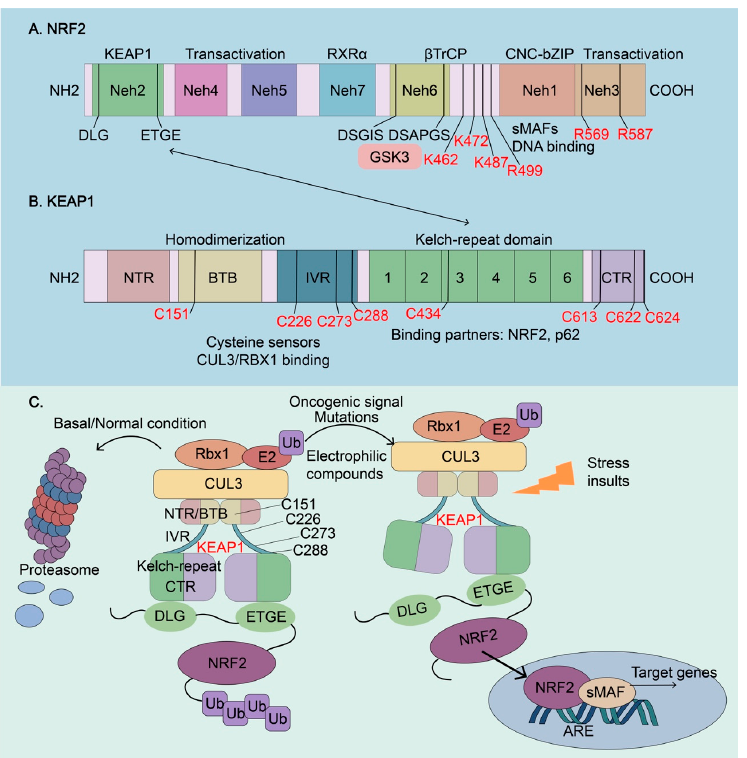
Figure 3. Molecular architectures of NRF2 and KEAP1 and regulation of NRF2 activity. ( A ) The architecture of NRF2. NRF2 has seven conserved NRF2-ECH homology (Neh) domains, Neh1-Neh7. Neh1, Neh4, and Neh5 are transactivation domains, where a basic leucine zipper (bZip) motif is responsible for DNA binding and dimerization with the other transcription cofactors, such as sMAFs. Neh2 contains ETGE and DLG motifs, which are required for the interaction with KEAP1